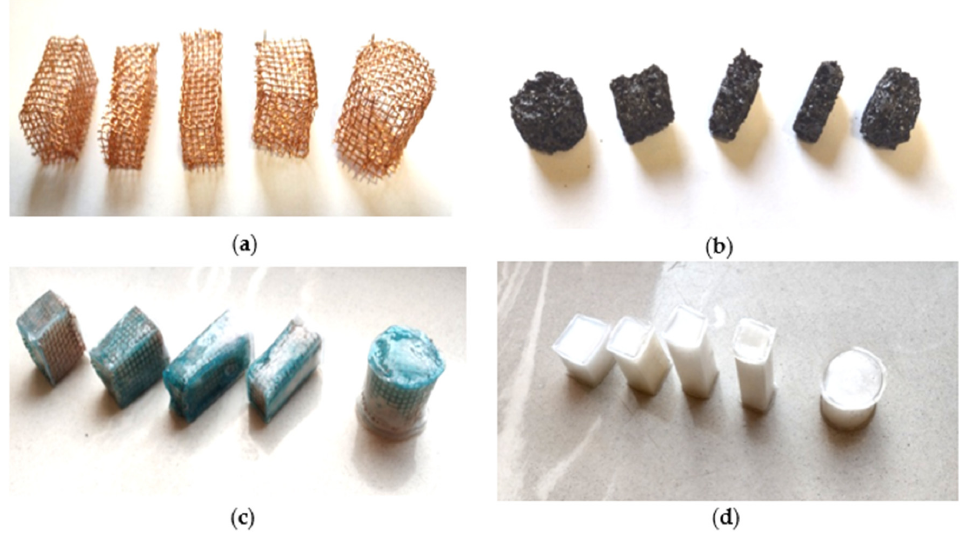
Figure 4. ( a ) Copper frameworks of the test specimens; ( b ) Cut shapes of the coke recyclate; ( c